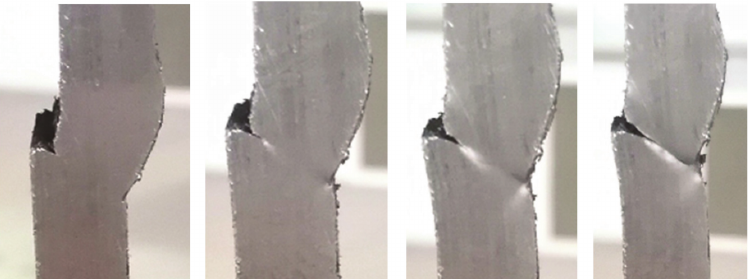
Figure 12. Tensile test specimens during the experiment (misalignment model with incomplete root penetration and undercut) from the initial state to